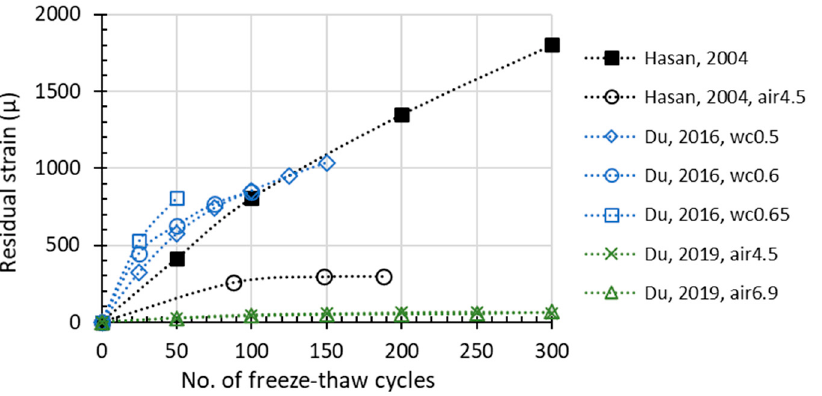
Figure 6. Residual strain (length change) development during FTC (“air” in the legend means entrained air amount, others are non-air-entrained concrete).